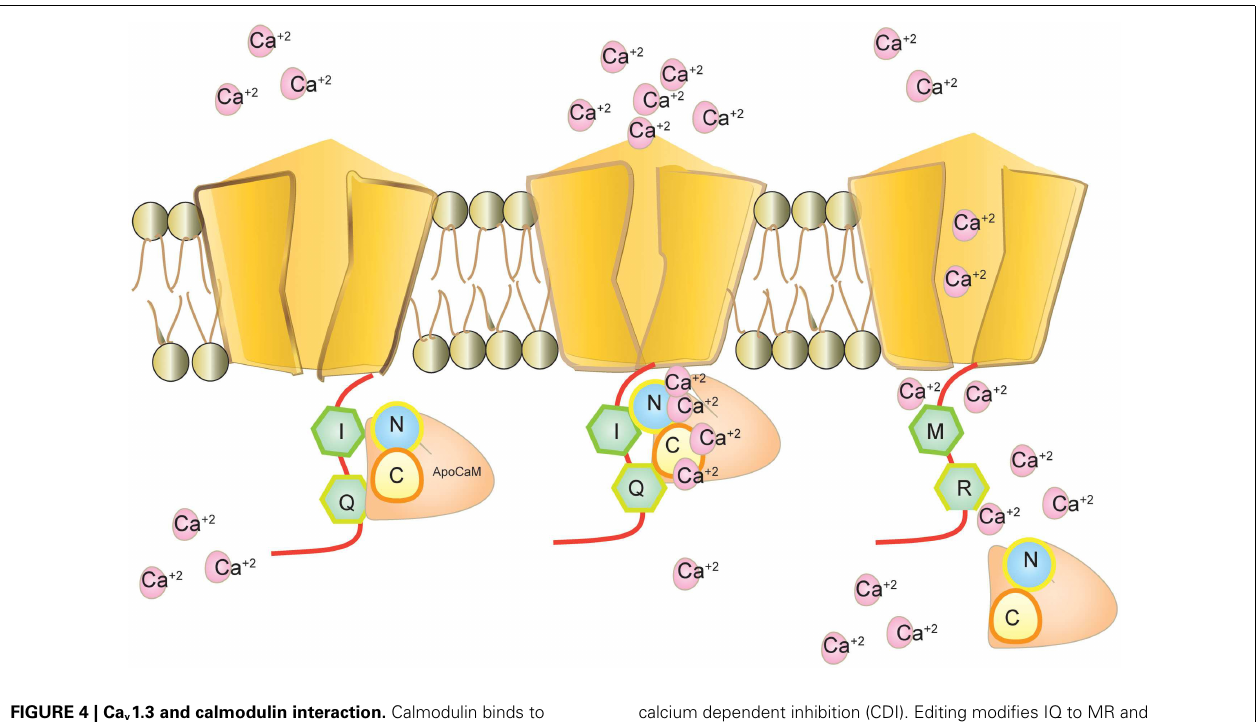
FIGURE 4 | Ca v 1.3 and calmodulin interaction. Calmodulin binds to Ca v 1.3 without calcium as apoCaM at the IQ motif. Calmodulin binds to calcium through its N-terminal and C-terminal loop and mediates